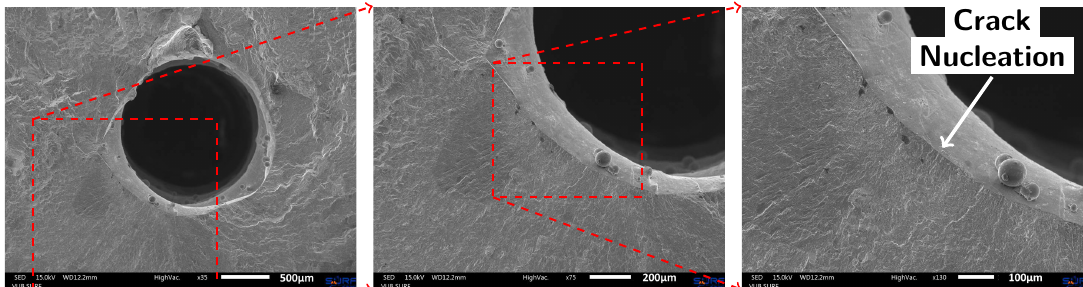
Figure 9. SEM images of the fracture surface of Specimen 9 (AM material with printed capillary) reveal that the fatigue crack initiated from a notch formed by the severe surface roughness at the